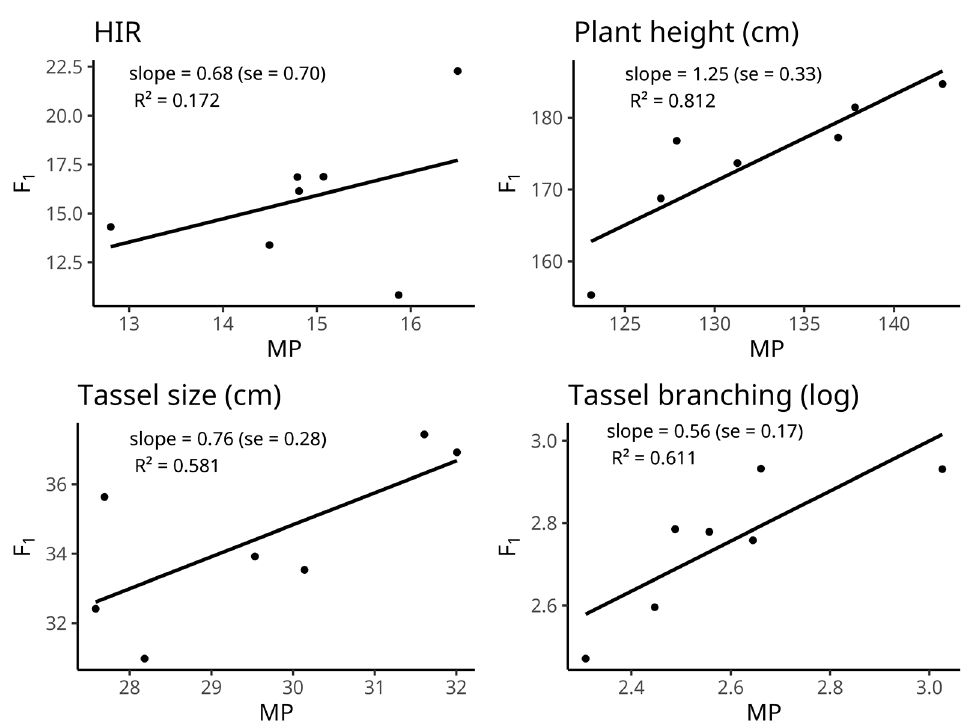
Figure 1. Linear regressions of hybrid performance (F 1 ) on mid-parent (MP), for haploid induction rate, plant height, tassel size, and tassel branching. Estimates (and s.e.’s) of the slopes averaged over the years, and R 2 values are shown. F 1 and MP values are also averaged over the years.